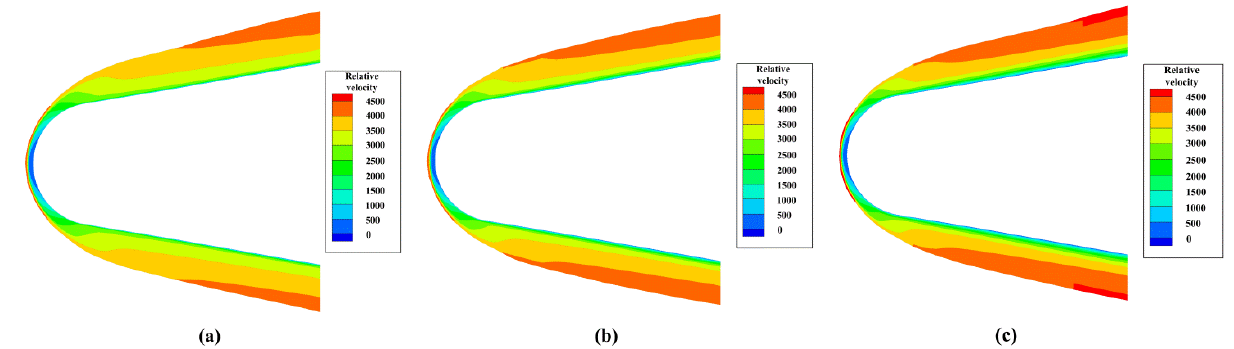
Figure 5. The velocity field distribution in scenes 1, 2, and 3. ( a ) Altitude is 30 km. ( b ) Altitude is 40 km. ( c ) Altitude is 50 km.